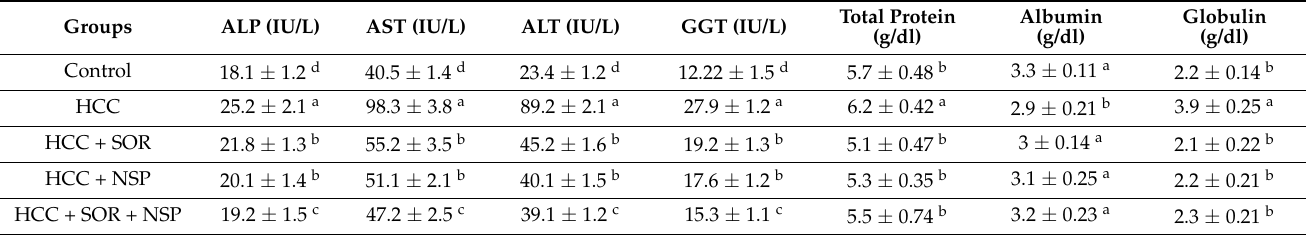
Table 3. Effects of SOR, NSP, and their combination in DENA-induced HCC biochemical parameters. Groups